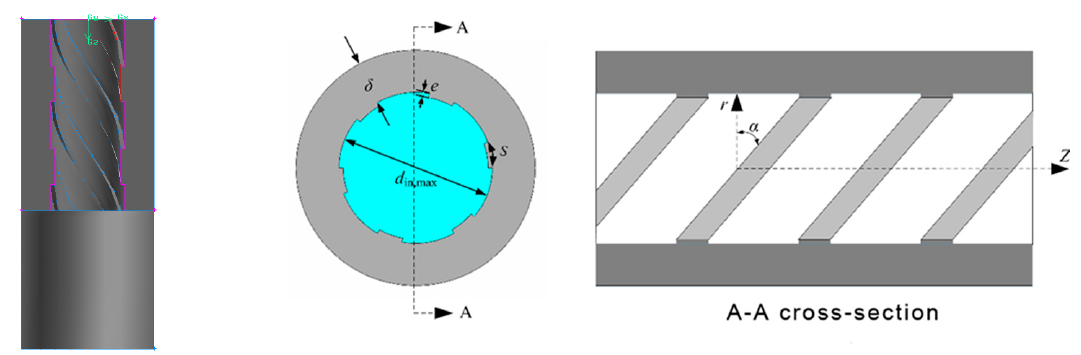
Figure 1. Schematic of internally ribbed tube (IRT) and its Structural Parameters in the Cross-section (where e is the rib height, S is the rib width, α is the rib lift angle, and α is defined as the angle between the spiral direction of the rib and the cross section of the pipe. Under the same pipe diameter, the larger the lift-angle of the thread, the larger the rib pitch).